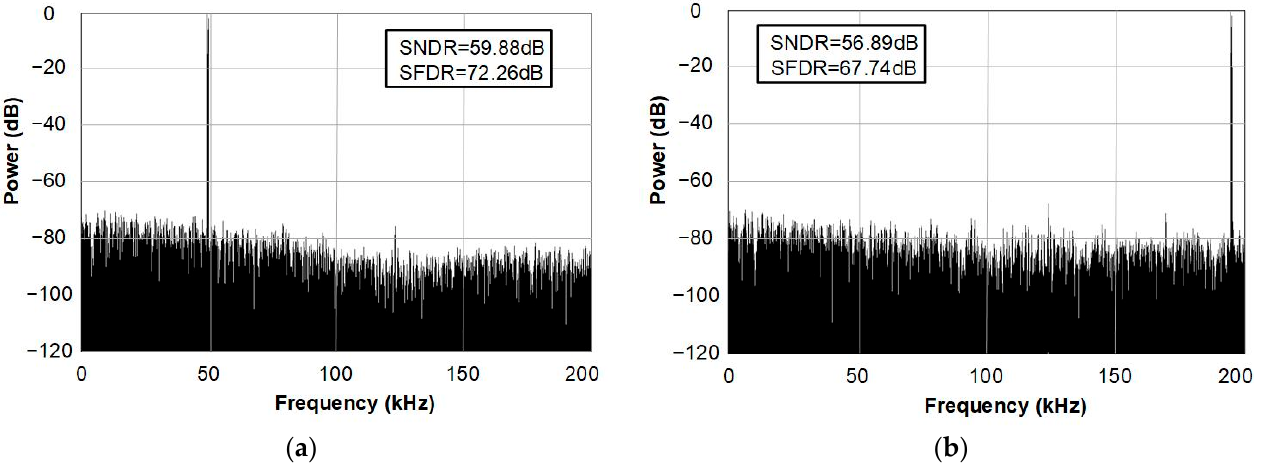
Figure 14. Measured dynamic performances at ( a ) different input frequencies and ( b ) Nyquist input.